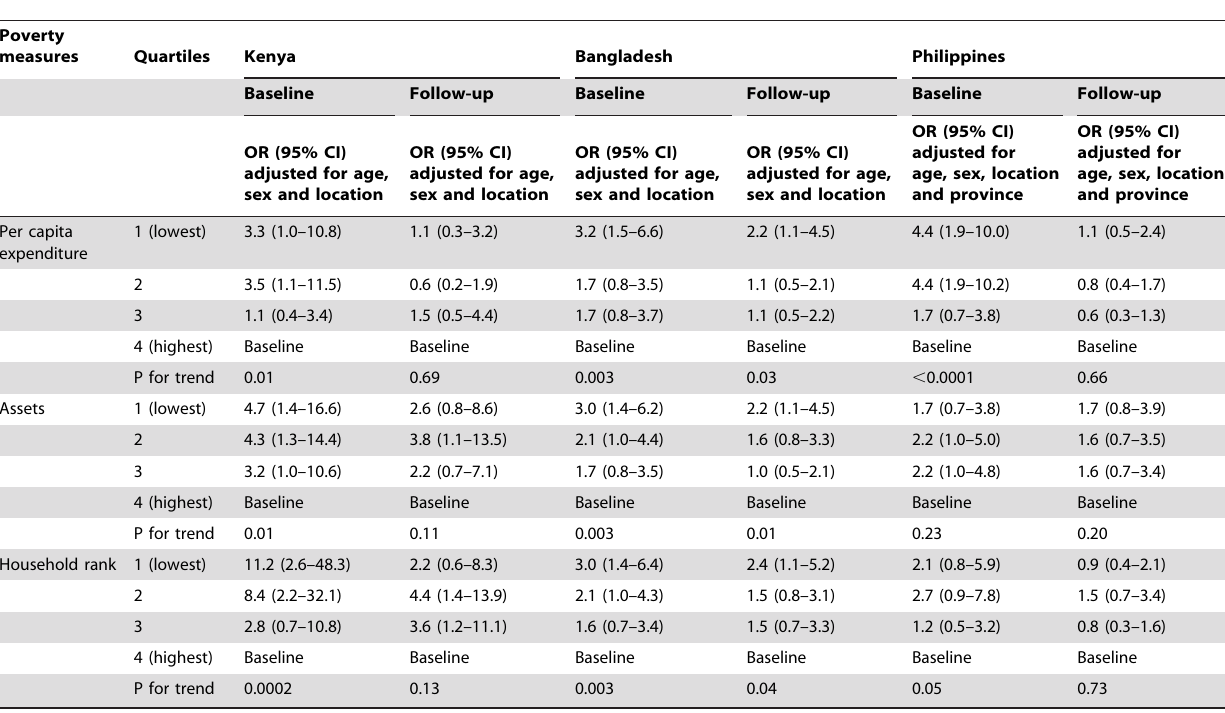
Table 4. Multivariable analyses for the comparison of poverty variables at baseline and follow-up among operated cases and